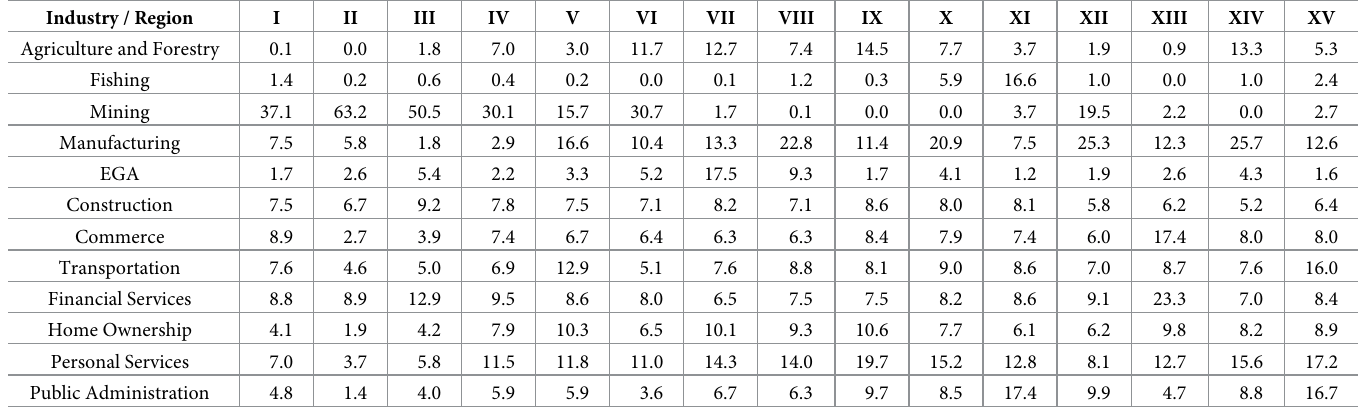
Table 2. Fraction (%) of the value of each industry for the GDP of each region (1985–2017). Industry /